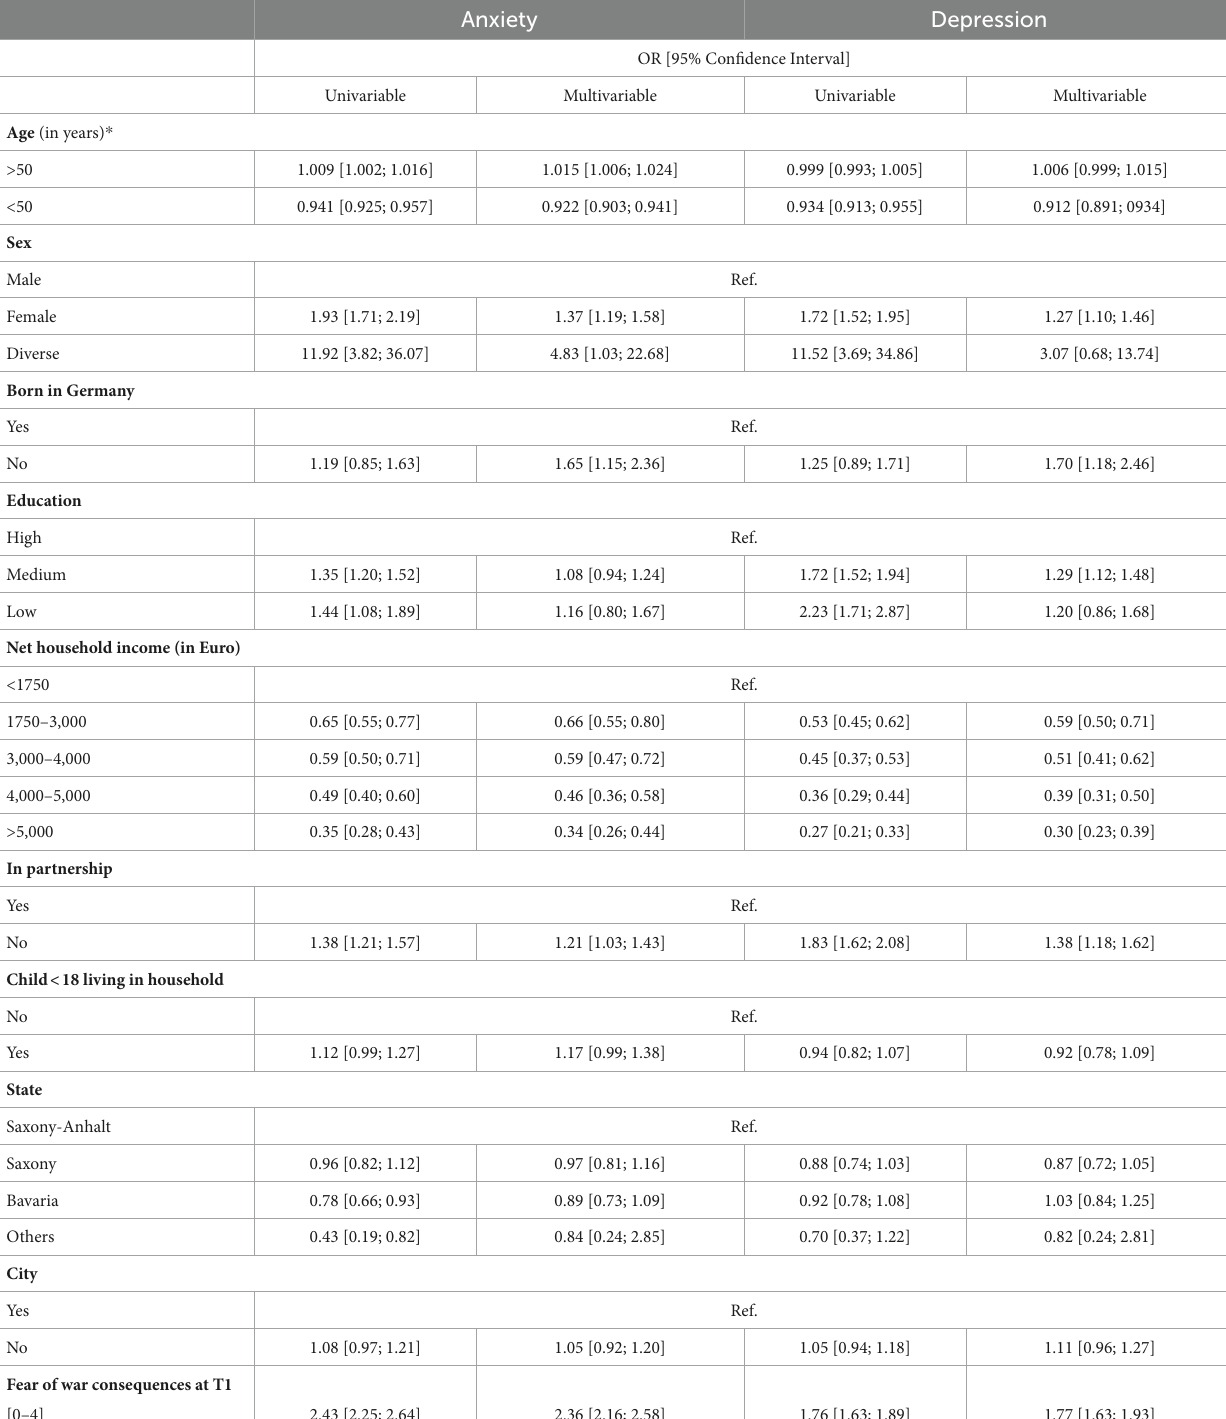
TABLE 2 Multi-and univariable logistic regression models for predictors of persistent anxiety and